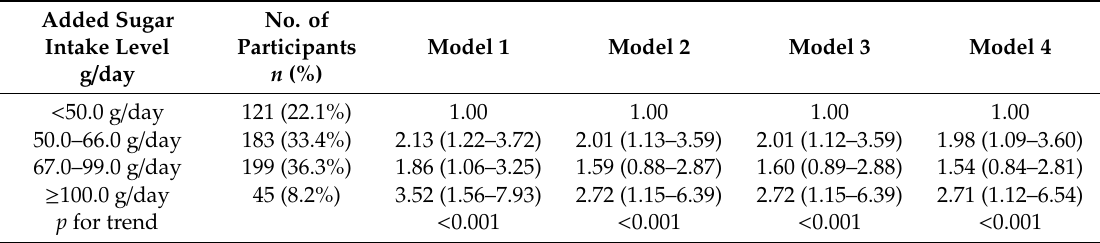
Table 2. Adjusted odds ratio (95% CI) of undiagnosed T2D by average daily added sugar intake ( n =